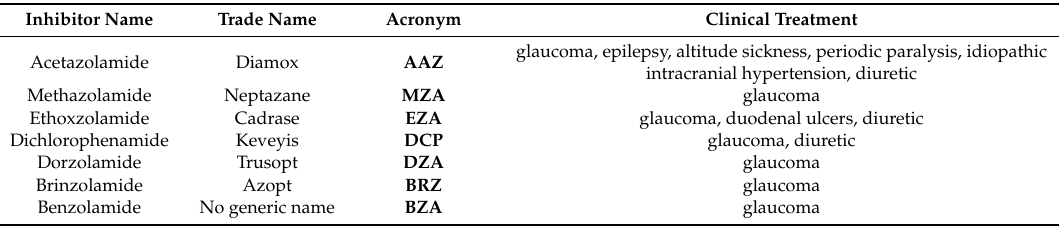
Table 2. Inhibitor name, commercial name, acronym, and clinical treatment of the CAI clinically used